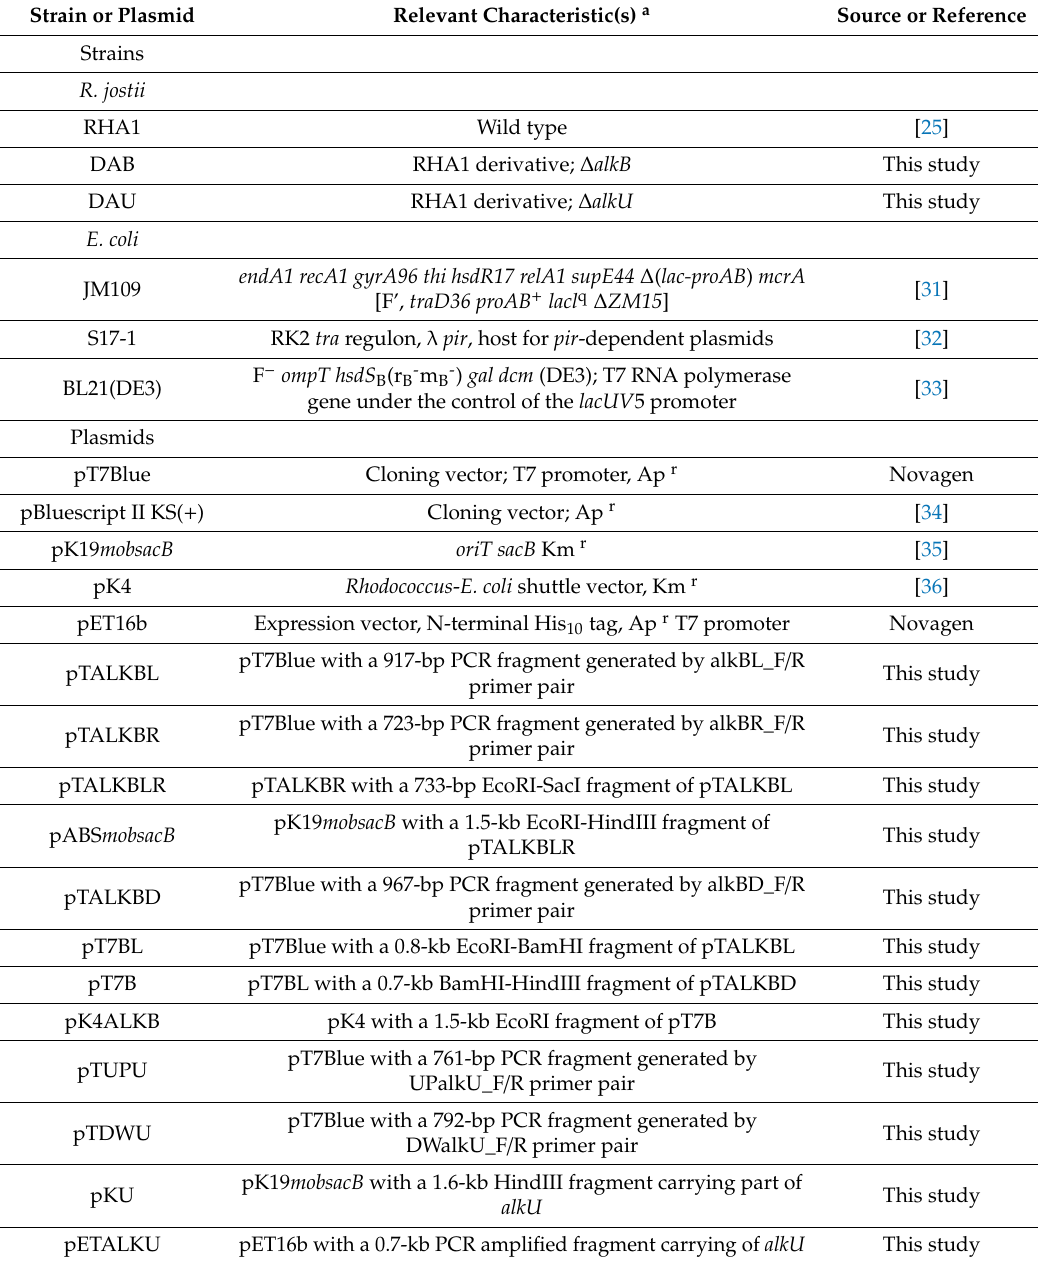
Table 1. Strains and plasmids used in this